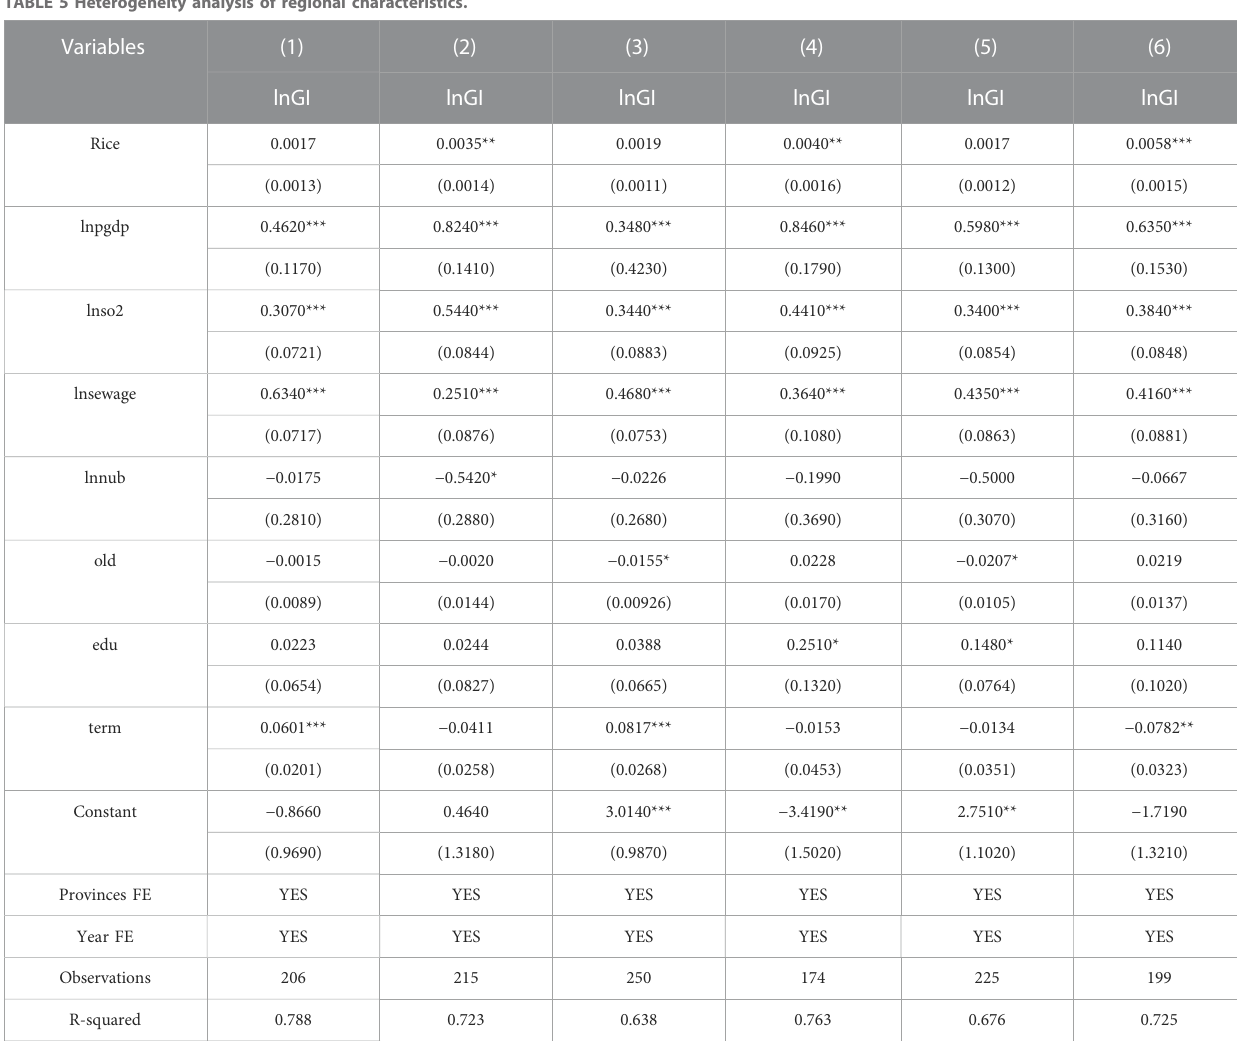
TABLE 5 Heterogeneity analysis of regional characteristics.